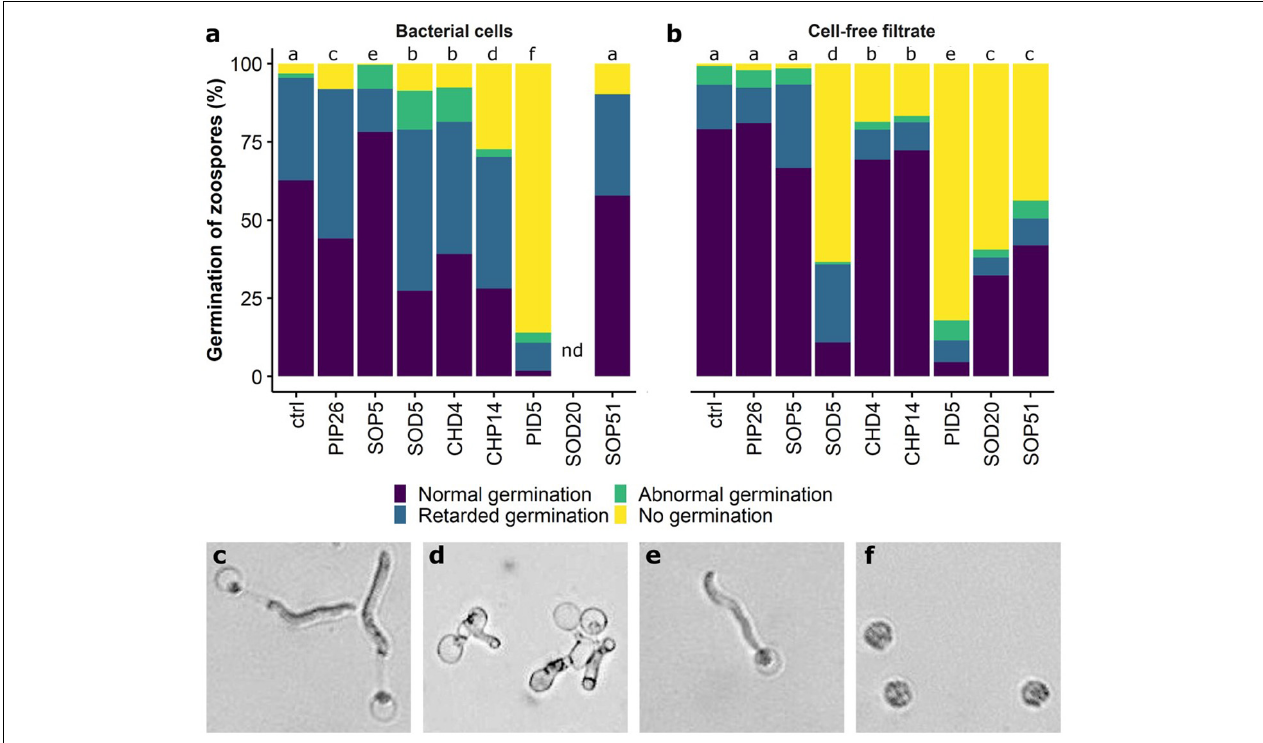
FIGURE 7 | Perturbed development of germinated zoospores of P. infestans. Proportions of anomalies observed in bacterial cell-exposed zoospores are shown in (a) , those observed in cell-free filtrate-exposed zoospores are shown in (b) . nd, no data (the visibility on the pictures was limited due to the presence of the bacteria). Different letters indicate significantly different proportions of anomalies according to a Chi-square test with Yate’s correction for continuity ( p < 0.05). The phenotypes observed in germinating zoospores of P. infestans are shown in (c–f) : (c) Normal germination; (d) abnormal germination; (e) retarded germination; (f) no germination. The experiment was repeated twice with similar results.